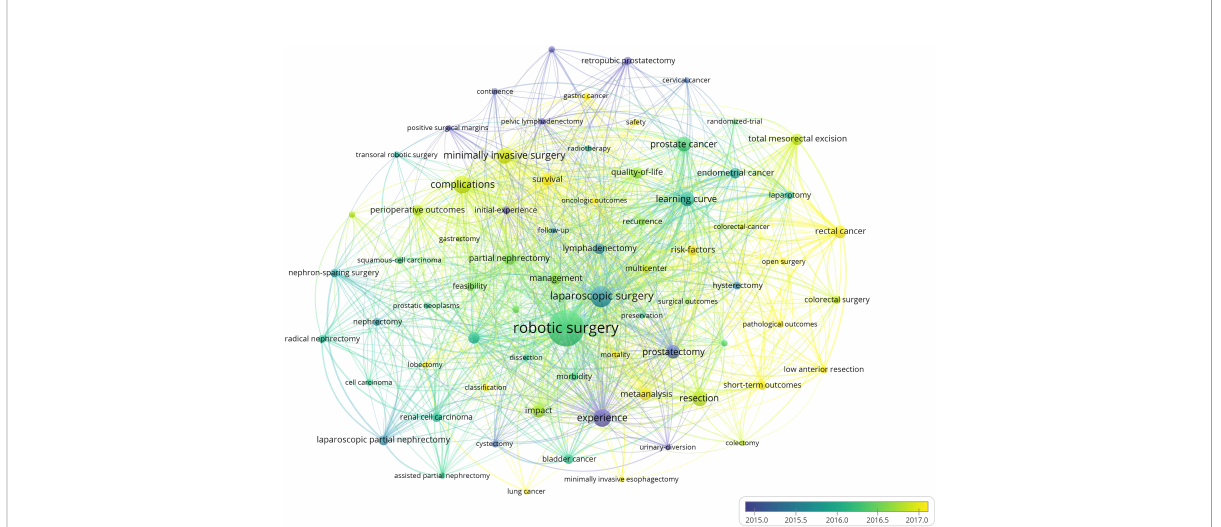
FIGURE 10 knowledge map of keywords co-occurrence network related to robotic surgery in oncology. The size of the nodes is proportional to the frequency of keywords occurrence. The warmer the color of the nodes, the later the average keywords appearance time. The lines between the nodes and the thickness of the lines represent the co-occurrence and co-occurrence strength of the keywords. From: